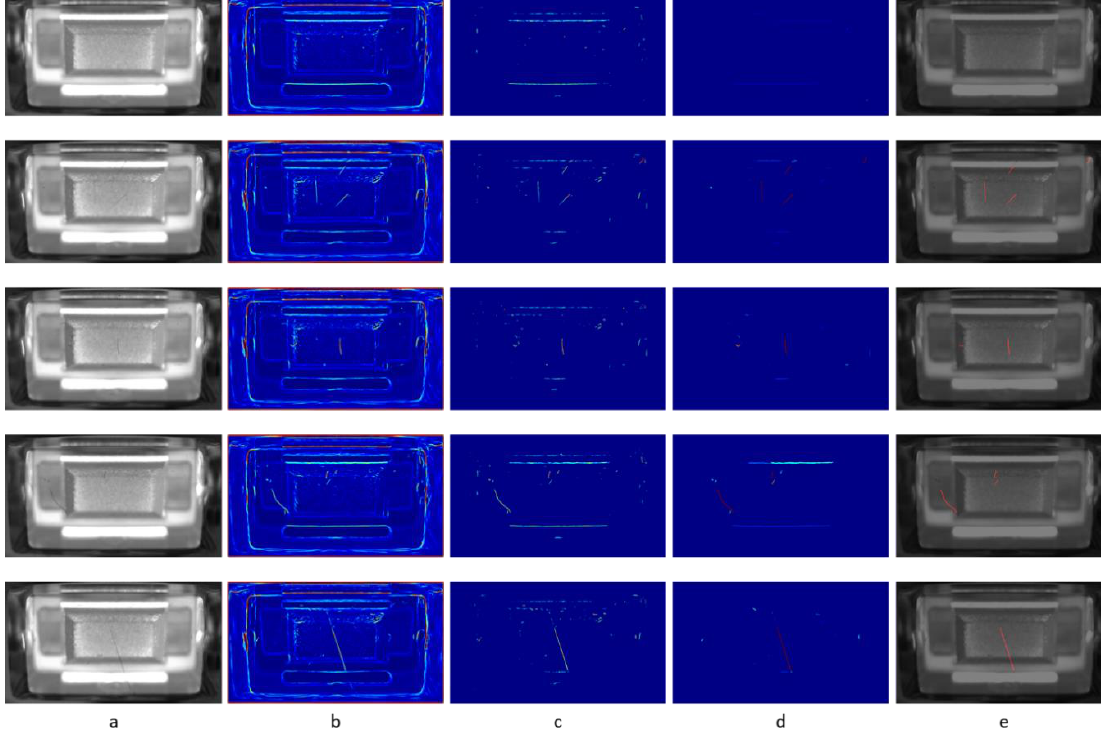
Figure 6. Five examples of inspected parts. Column ( a ) shows the registered input images to the pipeline. Note the slight variations of the surface appearance between the parts regardless of occurring defects. Column ( b ) shows the Frangi filtered images, ( c ) the difference filter images, ( d ) the anomaly score of the connected component in the difference filter images, and ( e ) the input image overlaid with the detected defects (red).